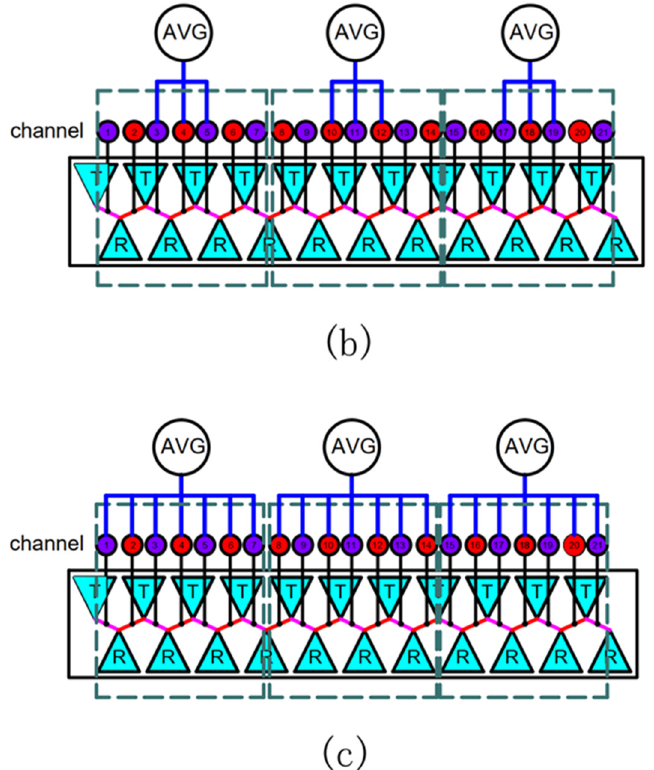
Figure 6. Experimental images of asphalt mixture tests used in this research: ( a ) Method 1, ( b ) Method 2, and ( c ) Method 3.